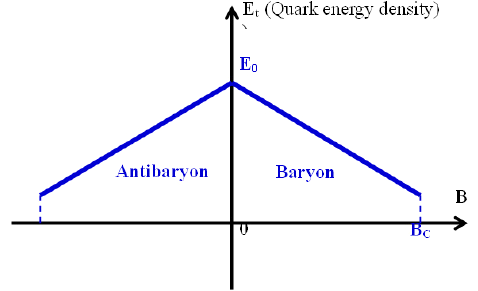
Fig. 4. Schematic diagram for the quark energy density E t as a function of baryon number B . An spontaneous symmetry breaking occurs due to the quark – quark potential after the collapse of packaged entangled states. With the expansion of universe, the baryon number stops increasing at the value j B C j where the total energy density (or temperature) of the universe reduced to the lowest value for creating new quarks/anti-quarks